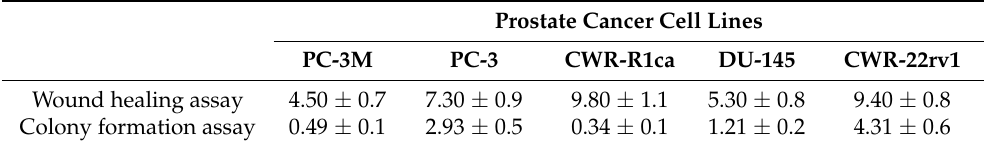
Figure 3. Effects of β -CBT treatments on the clonogenicity of PC-3M, PC-3, CWR-R1ca, DU-145 and CWR-22rv1 PC cells. ( a ) Representative images of PC colonies in control cells, and cell treated with β -CBT treatments for 13 days and stained with Giemsa at the end of the experiment. ( b ) Dose–response of different β -CBT concentrations and percent colony formation. Bar graphs represent the mean percent colony formation (± SD) at indicated concentrations ( μ M) relative to vehicle-treated control cells (CONT, 100% clonogenicity). *, **, *** indicate statistical significance relative to control cells at p < 0.05, p < 0.01, p < 0.001, respectively. Table 1. Calculated β -CBT IC 50 values ( μ M ± SD) in wound-healing and colony-forming assays using multiple human PC cells.